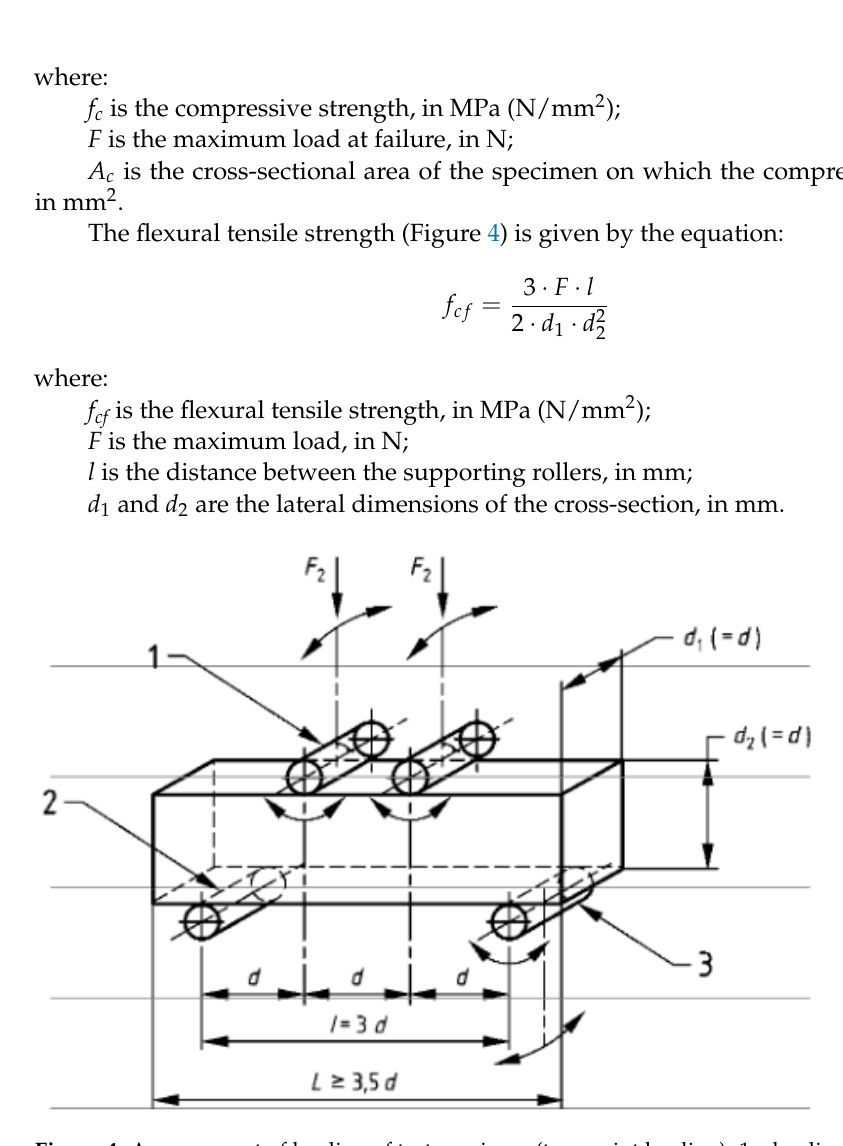
Figure 4. Arrangement of loading of test specimen (two-point loading): 1—loading roller (capable of rotation and of being inclined); 2—supporting roller; 3—supporting roller (capable of rotation and of being inclined).